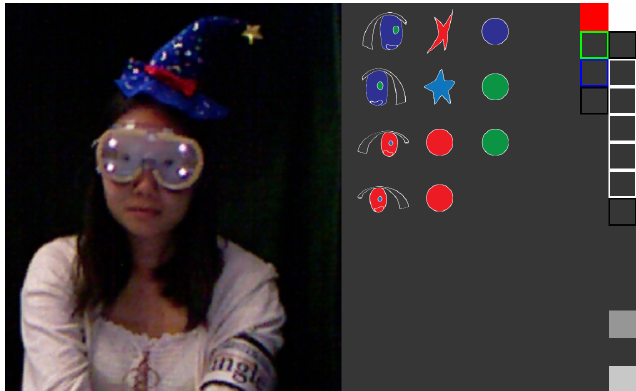
Fig. 3. Tablet interface. On the left half of the image, a participant with the goggles is shown. On the right half, stickers are displayed along with pen color selection buttons.